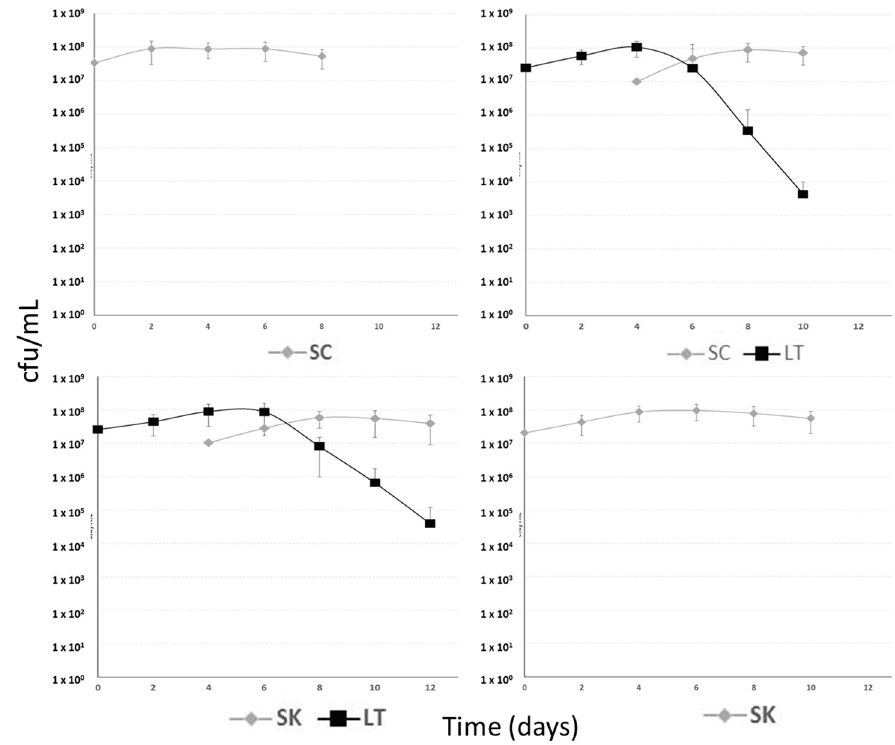
Figure 1. Population development during fermentation of S. cerevisiae 88 alone (SC), sequential fermentation with Saccharomyces cerevisiae 88 and L. thermotolerans CONCERTO™ (LT…SC), sequential fermentation with S. pombe V2 and Lachancea thermotolerans CONCERTO™ (LT…SK) and S. pombe V2 alone (SK).